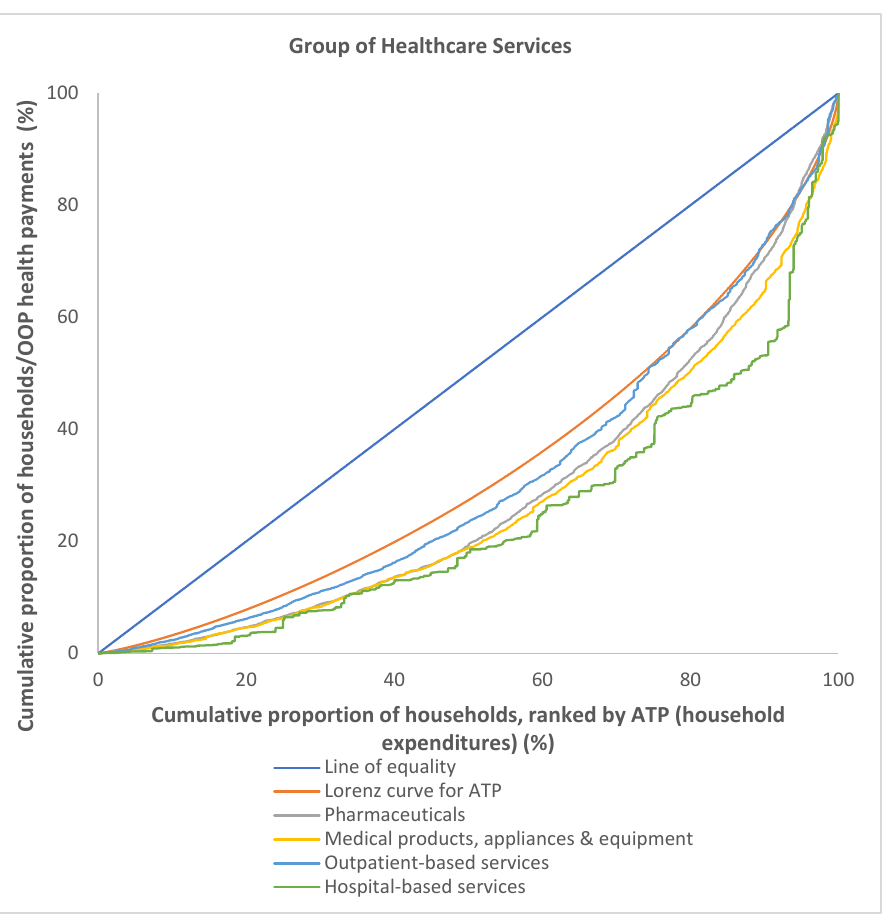
Figure 5. Concentration curves for OOP payments by group of healthcare services, Malaysia 2014/2015.